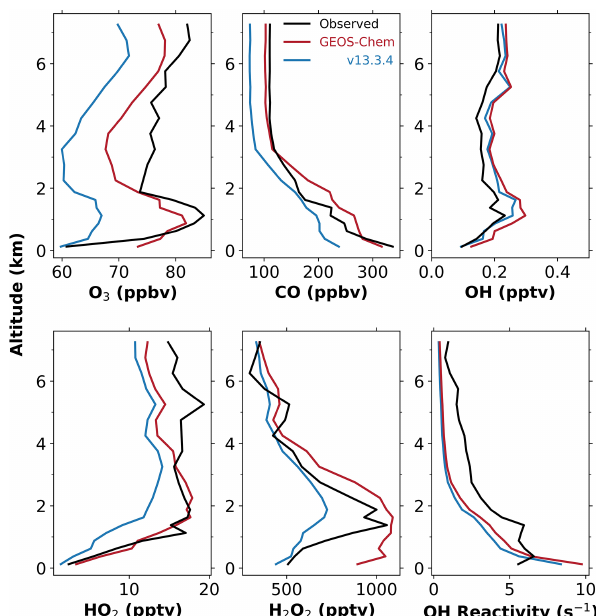
Figure 2. Median vertical profiles of species concentrations and OH reactivity (OHR) in the Seoul metropolitan area (SMA; 37– 37.6 ◦ N, 126.6–127.7 ◦ E) during KORUS-AQ. Observations are compared to our GEOS-Chem simulation and to the standard ver- sion 13.3.4 of the model. Here and in the following figures, vertical profiles are constructed by binning the data into 0.25km vertical in- tervals below 2km altitude and 1km vertical intervals above 2km